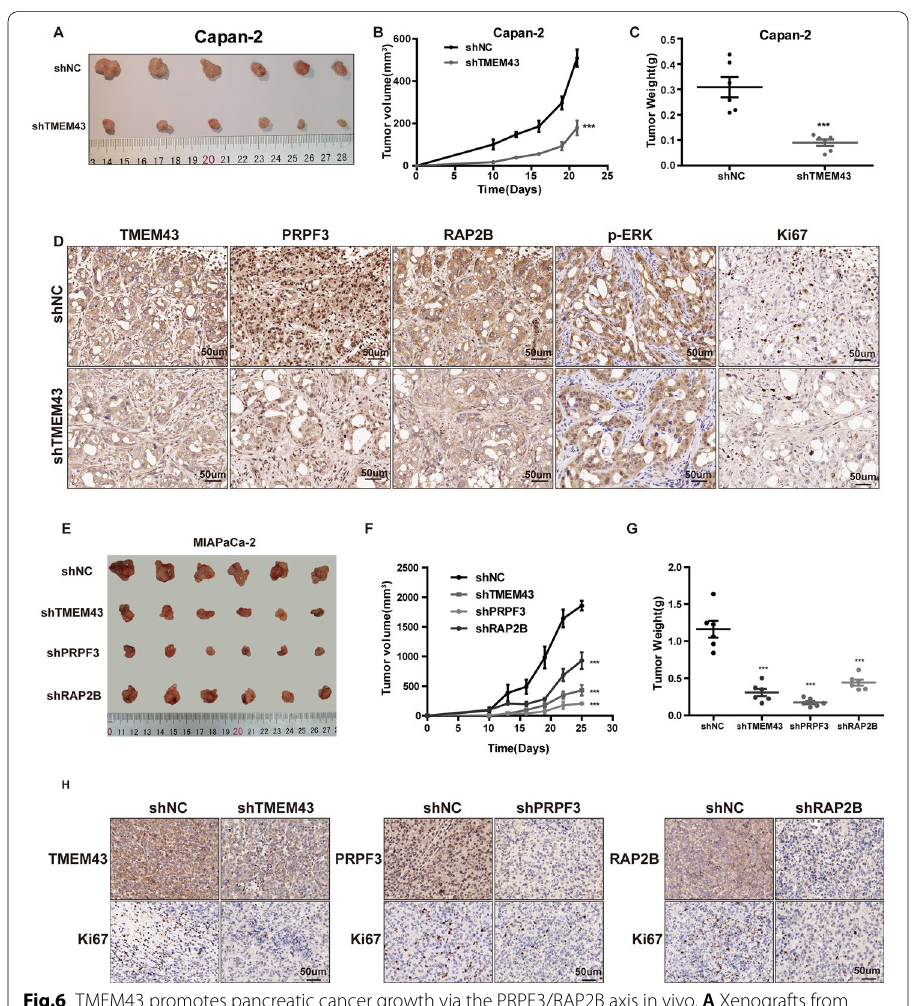
Fig.6 TMEM43 promotes pancreatic cancer growth via the PRPF3/RAP2B axis in vivo. A Xenografts from nude mice were obtained and measured. B The tumor volume in nude mice was detected and analyzed every three days in the TMEM43-silenced Capan-2 cells group and the control group. C Tumor weights were measured and analyzed in the TMEM43-silenced Capan-2 cells group and the control group. D IHC detected the expression of the indicated proteins in the two groups. E Xenografts from nude mice were obtained and measured after different treatments. F The tumor volume in nude mice were detected and analyzed every three days after different treatments. G Tumor weights were measured and analyzed after different treatments. H IHC detected the expression of the indicated proteins after different treatments. Results are shown as the mean SD of three independent replicates. Scale bar 50 μm * p < 0.05, ** p < 0.01, *** p < ± =